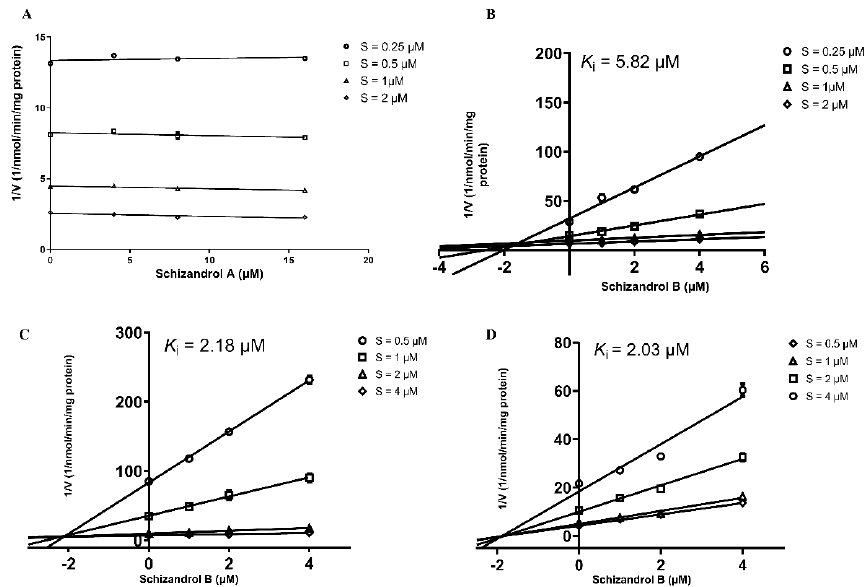
Figure 2. Dixon plots of SZA ( A ) and SZB ( B ) on tacrolimus metabolism mediated by CYP3A metabolism in pooled HLMs. Various concentrations of tacrolimus (0.25, 0.5, 1, 2 µ M), SZA (0, 4, 8, 16 µ M) and SZB (0, 1, 2, 4 µ M) were used. Dixon plot of SZB on CYP3A4 ( C ) and CYP3A5 ( D ) in genotyped HLMs. Various concentrations of tacrolimus (0.5, 1, 2, 4 µ M) and SZB (0, 1, 2, 4 µ M) were used. Experiments were conducted in triplicates.